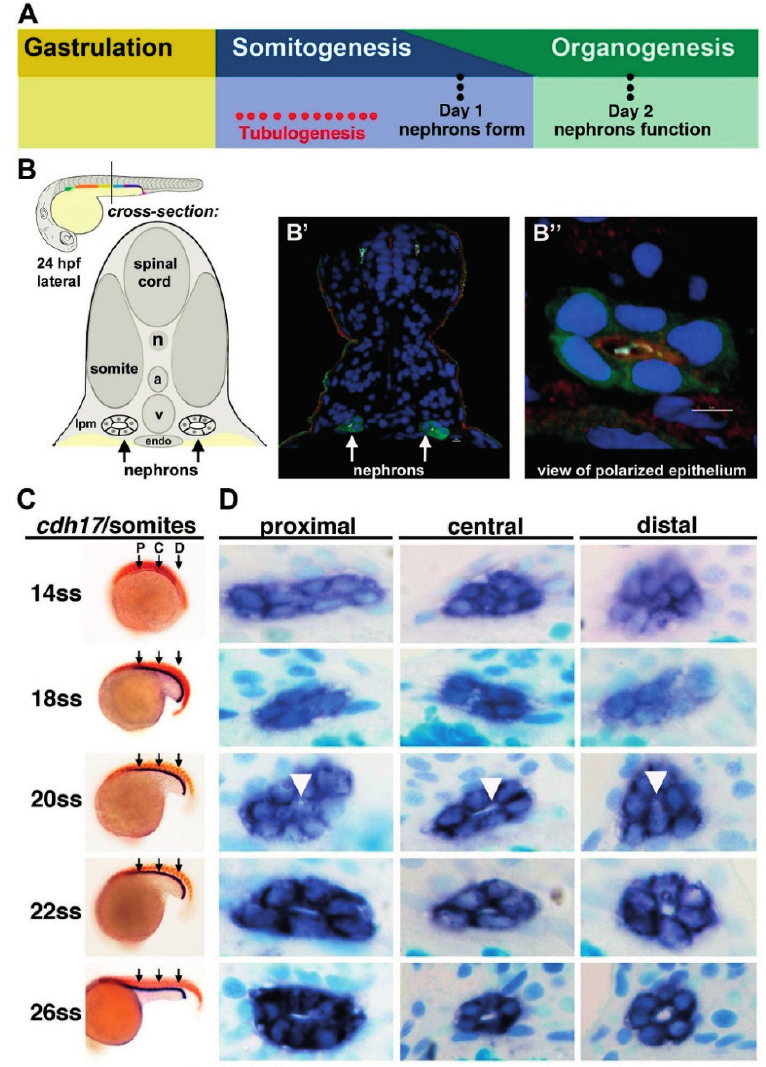
Figure 2. Tubulogenesis of the zebrafish pronephros. ( A ) The timing of tubulogenesis is coincident with the stages of somitogenesis and organogenesis of the embryo; ( B – B ”) At 24 hours post fertilization (hpf), the two nephrons have formed distinct tubule lumens that can be detected by immunofluorescence to detect green fluorescent protein (GFP), acetylated tubulin (light blue), Prkc ι / ξ (red) and nuclei (DAPI, blue); ( C , D ) The precise onset of tubulogenesis occurs at the 20 ss, indicated by white arrowheads, along the proximal, central, and distal regions of the nephron territory, with progressive enlargement of the luminal space at 22 and 26 ss. Abbreviations: aorta (a), lateral plate mesoderm (lpm) notochord (n), somite stage (ss) cardinal vein (v), [Figure adapted from [43,57],